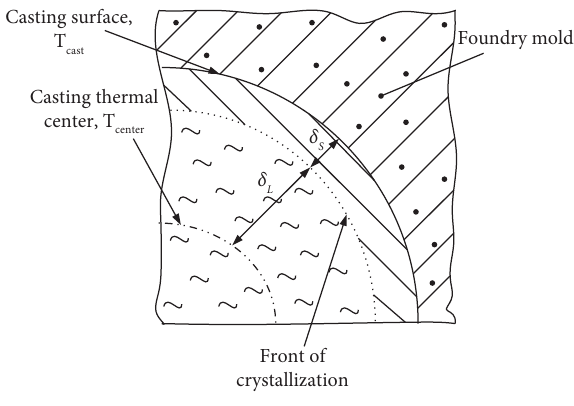
Figure 5: Scheme to determine the temperature distribution in the liquid and crystallized parts of the